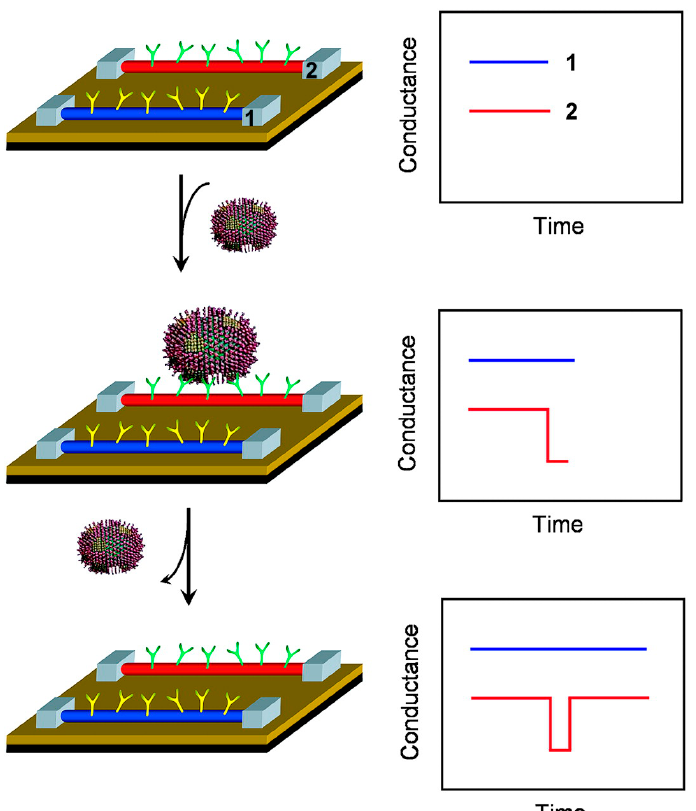
Figure 8. Nanowire-based detection of single viruses. ( Left ) Schematic shows two nanowire devices, 1 and 2, where the nanowires are modified with different antibody receptors. Specific binding of a single virus to the receptors on nanowire 2 produces a conductance change ( Right ) characteristic of the surface charge of the virus only in nanowire 2. When the virus unbinds from the surface the conductance returns to the baseline value. Reprinted with permission from PNAS, 2004. 101(39): pp. 14017–14022. [49].